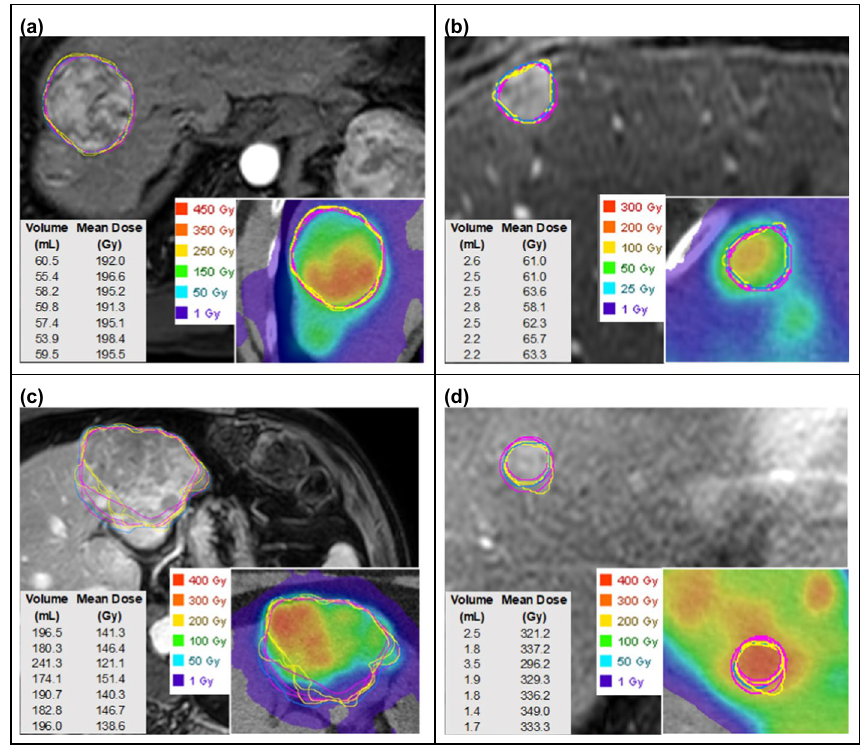
Fig. 2 Radiologist-defined tumor contours on MRI corresponding to the four example lesions depicted in Fig. 1. Inserts show contours transferred to co-registered Y-90 PET/CT-based dose maps. Mean dose values are indicated before PVC. a Large, well defined (code 46.1). b Small, well defined (39.3). c Large, poorly defined (49.1). d Small, poorly defined (55.4). Contours drawn by the same radiologist are indicated in the same color (Pink radiologist A, Yellow radiologist B, Blue radiologist = = =